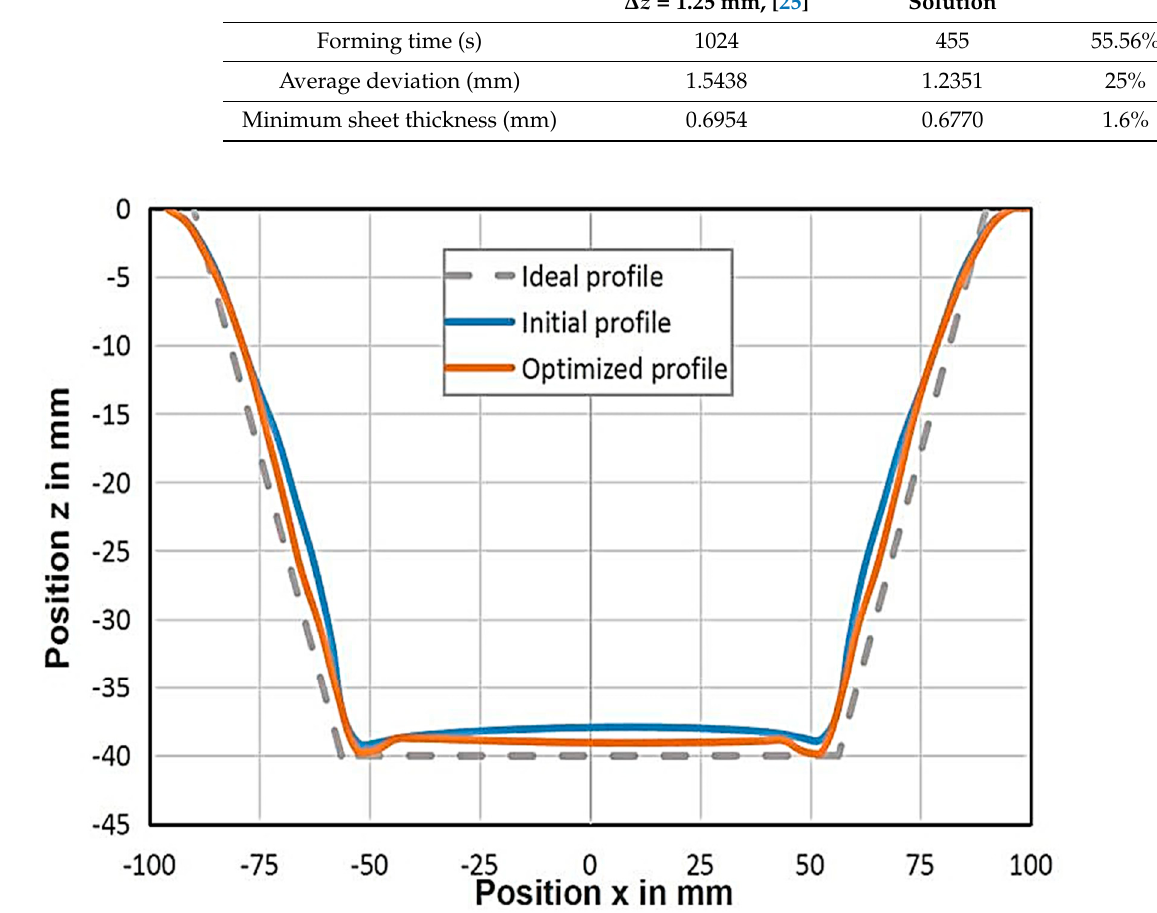
Figure 10. Section of the formed part produced using the single-stage process [25] and the optimised multistage process and ideal part. Table 5. Comparison between the forming time, average deviation and minimum sheet thickness.